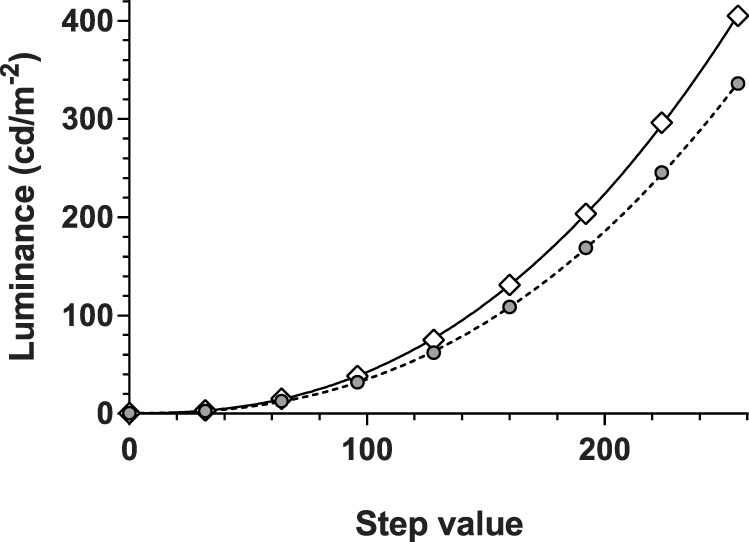
Luminance calibration of two iPad tablet screens: iPad2 (gray circles) and iPad3 (unfilled diamonds). Both return similar gamma functions (2.4, lines) but the iPad2 tablet is consistently dimmer than is the iPad3 due to its lower amplification. This results in a dimmer background level for testing on the iPad2 (4.2 vs. 5.0 cd.m−2) but has no practical impact on the dynamic range (30.8 vs. 31.4 dB) as the smaller steps are proportionately scaled by the higher amplification constant.